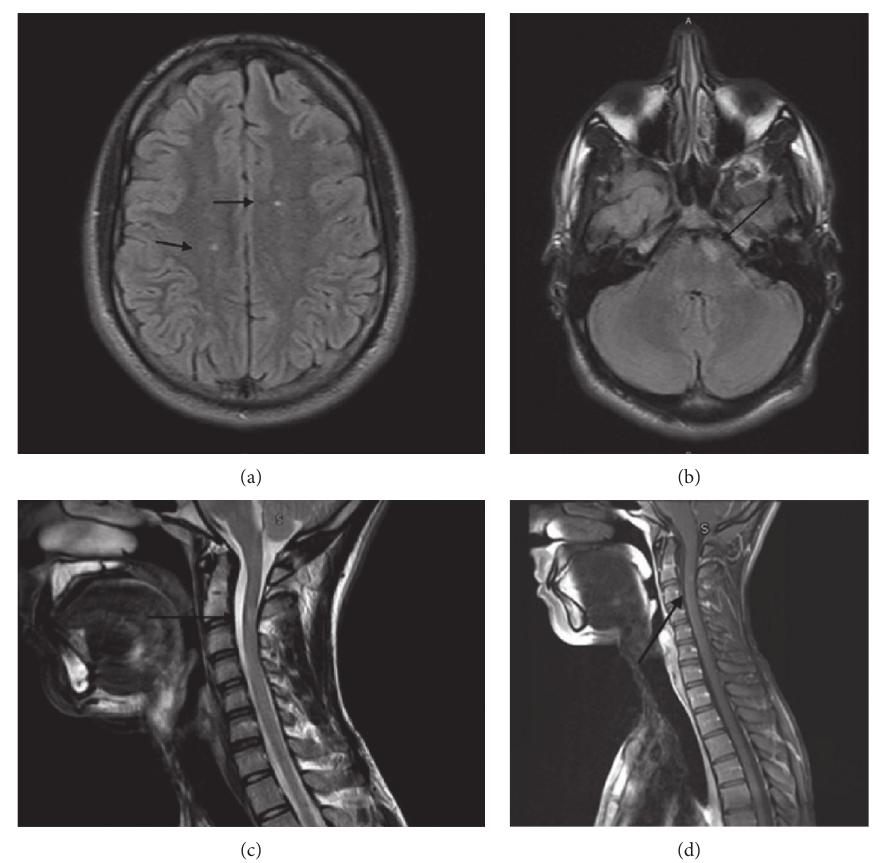
Figure 1: (a) There are few small foci of T2 and FLAIR hyperintensity noted in the periventricular white matter (bilaterally), perpendicular to the ventricular margin. (b) There is a small area of T2 and FLAIR hyperintensity noted in the left paramedian anterior pons. ((c), (d)) There is a small area of T2 hyperintensity with corresponding postcontrast enhancement noted in the cervical spinal cord at the C2-C3